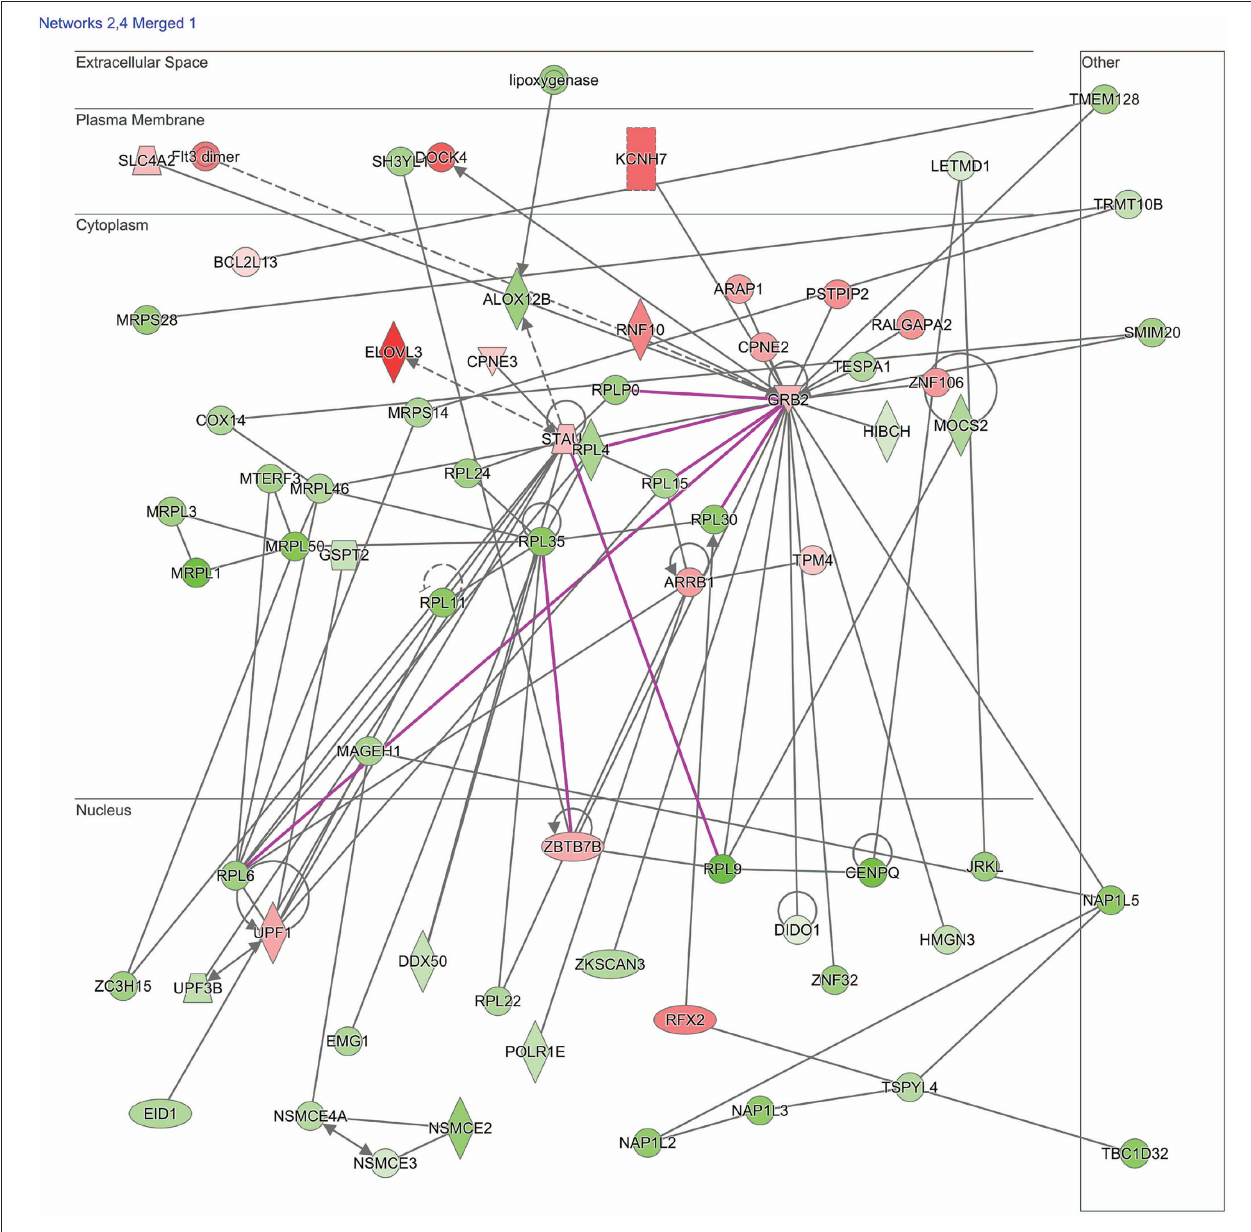
FIGURE 1 | Network shows dysregulated cell death and survival pathway following moderate blast. Genes described in the text included: UPF1, UPF3B, ARRB1, ZBTB7B, flt3, HIBCH, RPL6, RPL35, MRPL1, MRPL3, MRPL36, and MRPL50 . Red indicates increased measurement; green represents decreased measurement; with increased color saturation representing more extreme measurement in dataset. Solid lines represent direct interactions, non-targeting interactions, or correlations between chemicals, proteins, or RNA. Dotted lines represent indirect interactions. Purple lines denote the commonly found relationship among the two merged networks. Arrowed lines represent activation, causation, expression, localization, membership, modification, molecular cleavage, phosphorylation, protein-DNA interactions, protein-RNA interactions, regulation of binding, transcription. Shapes represent molecule type (double circle, complex/group; square, cytokine; diamond, enzyme; inverted triangle, kinase; circle, other; triangle, phosphatase; oval, transcription regulator; trapezoid, transporter). The network was generated through the use of IPA (QIAGEN Inc.,